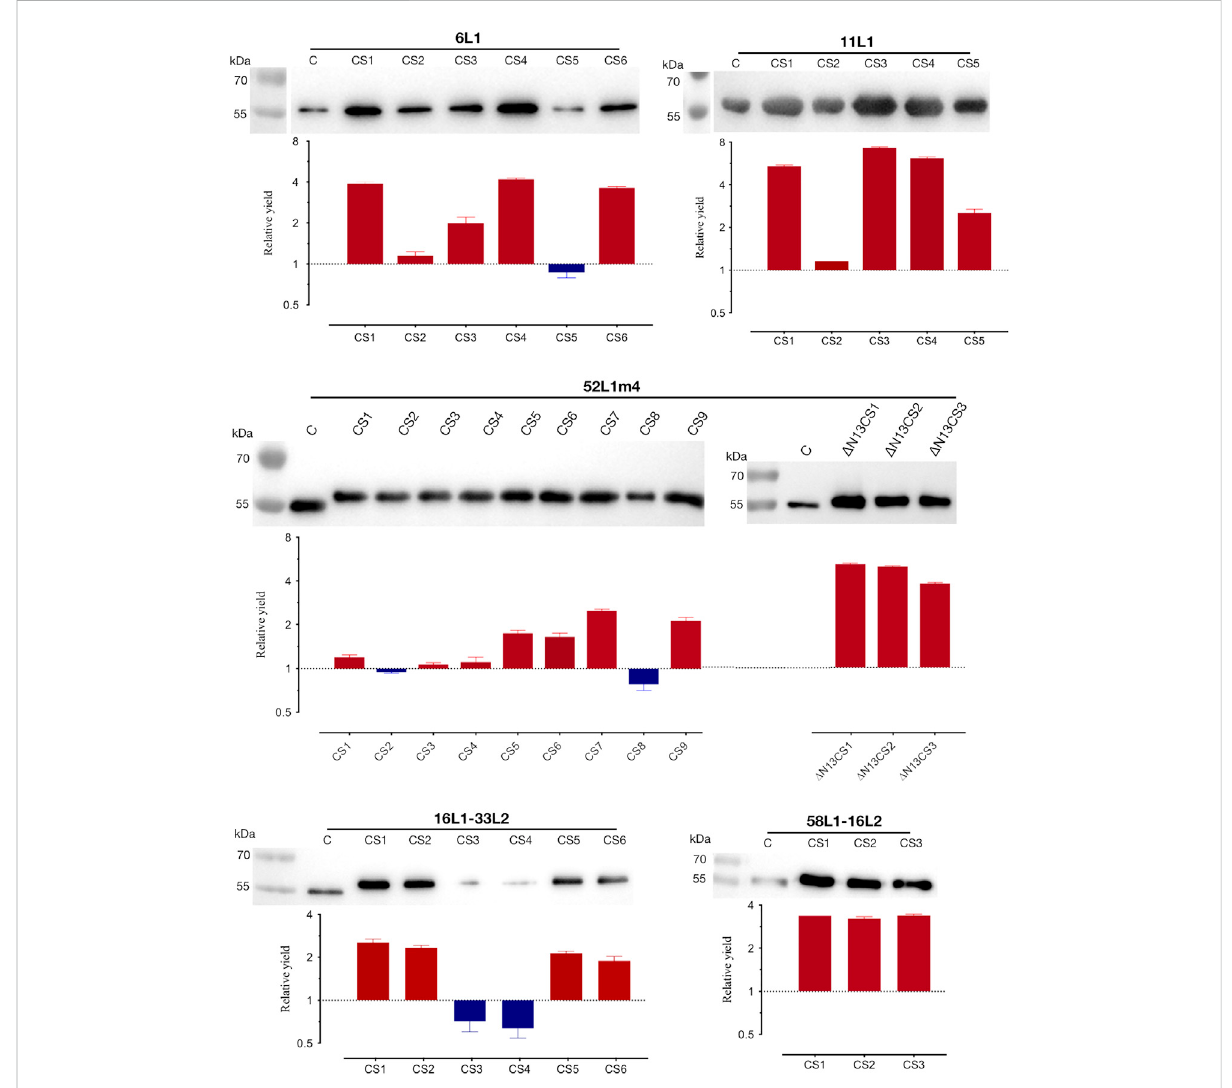
AnalysisofproteinexpressionandyieldsoftheC-terminalsubstitutionsof6L1,11L1,52L1,16L1-33L2,and58L1-16L2.Eachlanewasloadedwith 600 ng of whole-cell proteins for expression analysis by western blot, and L1 proteins were probed with mAb Camvir-1. Histograms depict fold- change in yields of puri fi ed proteins after C-terminal substitutions. The red and blue bars represent an increase or decrease in yields. Results represent three biological repeats. Data are presented as means ±